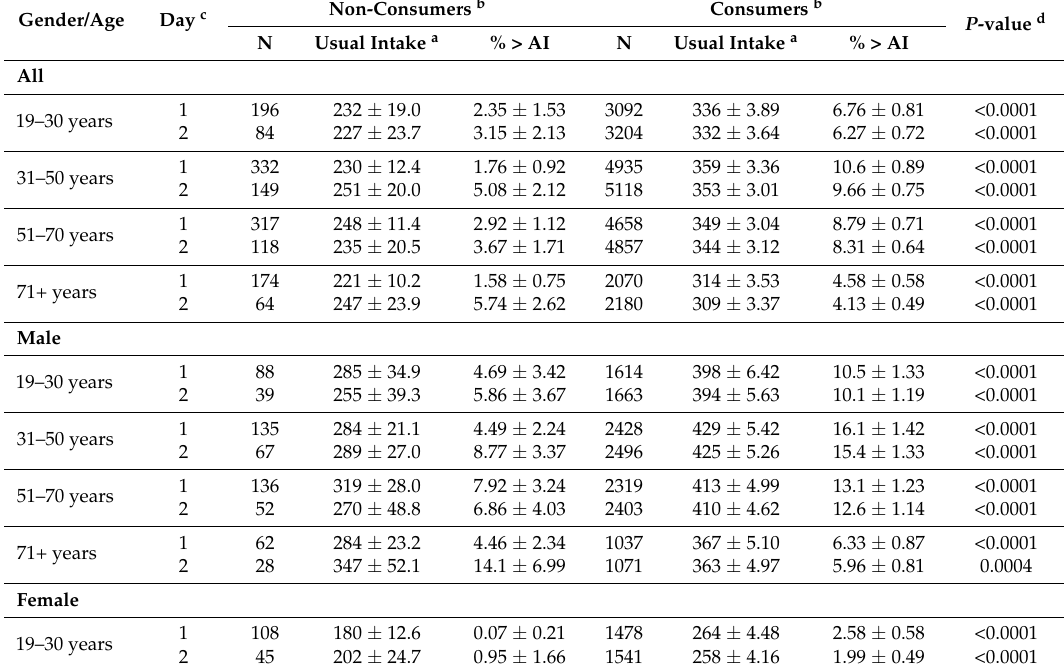
Table 5. Choline intakes among consumers vs. non-consumers of protein foods (meat, poultry and